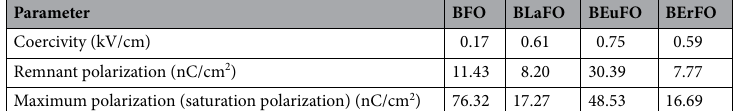
Table 3. The values of coercivity, remnant polarization, and saturation polarization for neat and doped BFO materials.